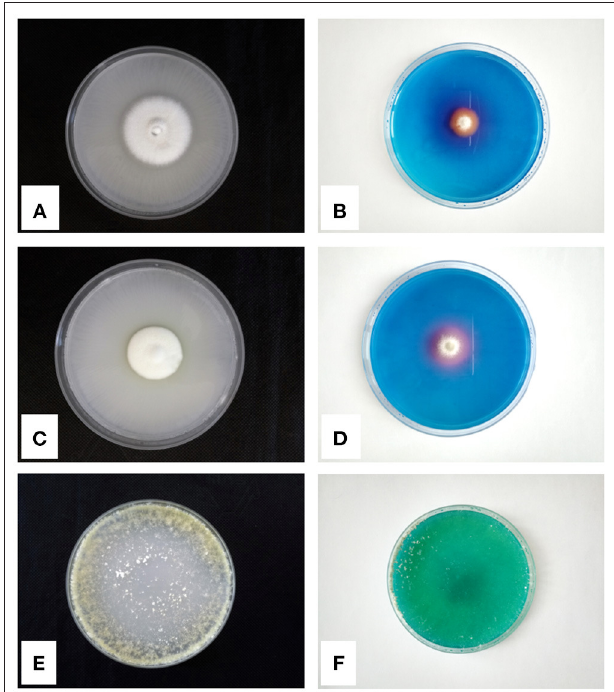
FIGURE 1 | P-solubilization tests on Pikovskaya Agar and siderophores production tests on CAS-Agar of Penicillium ochrochloron (A,B) , Penicillium canescens (C,D) , and Trichoderma harzianum (E,F) ,